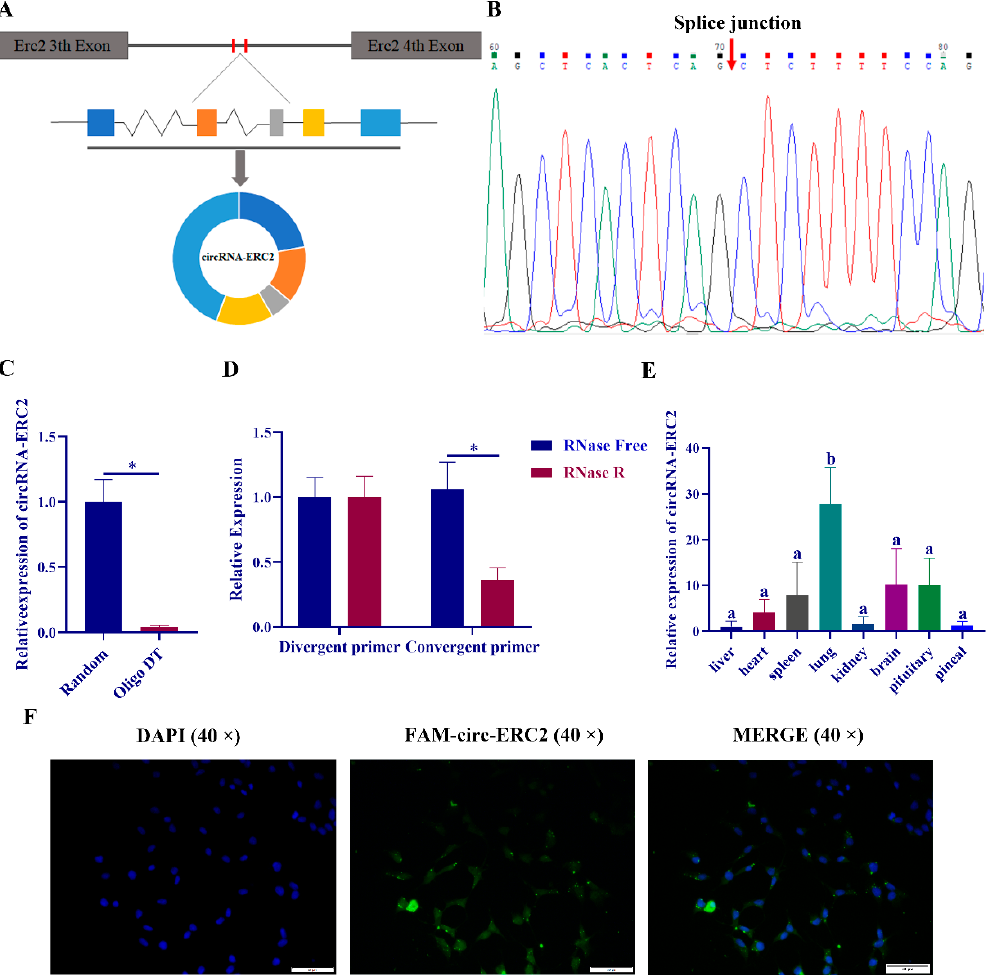
Figure 4. Structural identification and cellular localization of circ-ERC2 in rat pineal gland. ( A ) Chro- mosomal localization of circR-ERC2. ( B ) Identification of the circR-ERC2 sequence. ( C ) Relative expression of circR-ERC2 with oligo (dT) or random reverse transcription primers. ( D ) Expression of circ-ERC2 and linear-ERC2 before and after linear RNase treatment. ( E ) Relative expression of circ-ERC2 in different tissues of rats. The letters (a, b) mean there are significant differences among them. ( F ) Representative images of FISH show the localization of circR-WNK2 (green). Nuclei were counterstained with DAPI (blue). *, p < 0.05.